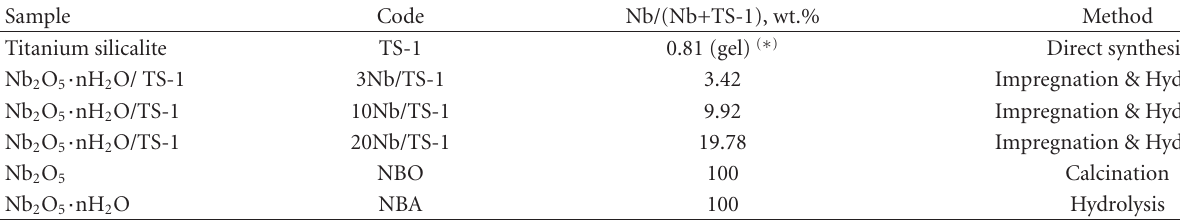
Table 1: Chemical compositions of the samples and preparation method.